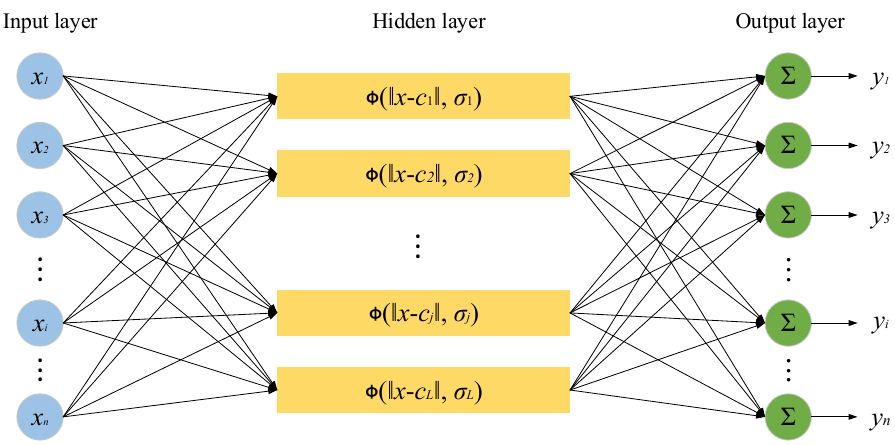
Figure 1. The structure of radial basis function neural network. Due to strong global mapping capability, RNFNN is considered as one of the best feedforward neural networks with good performance in classification and